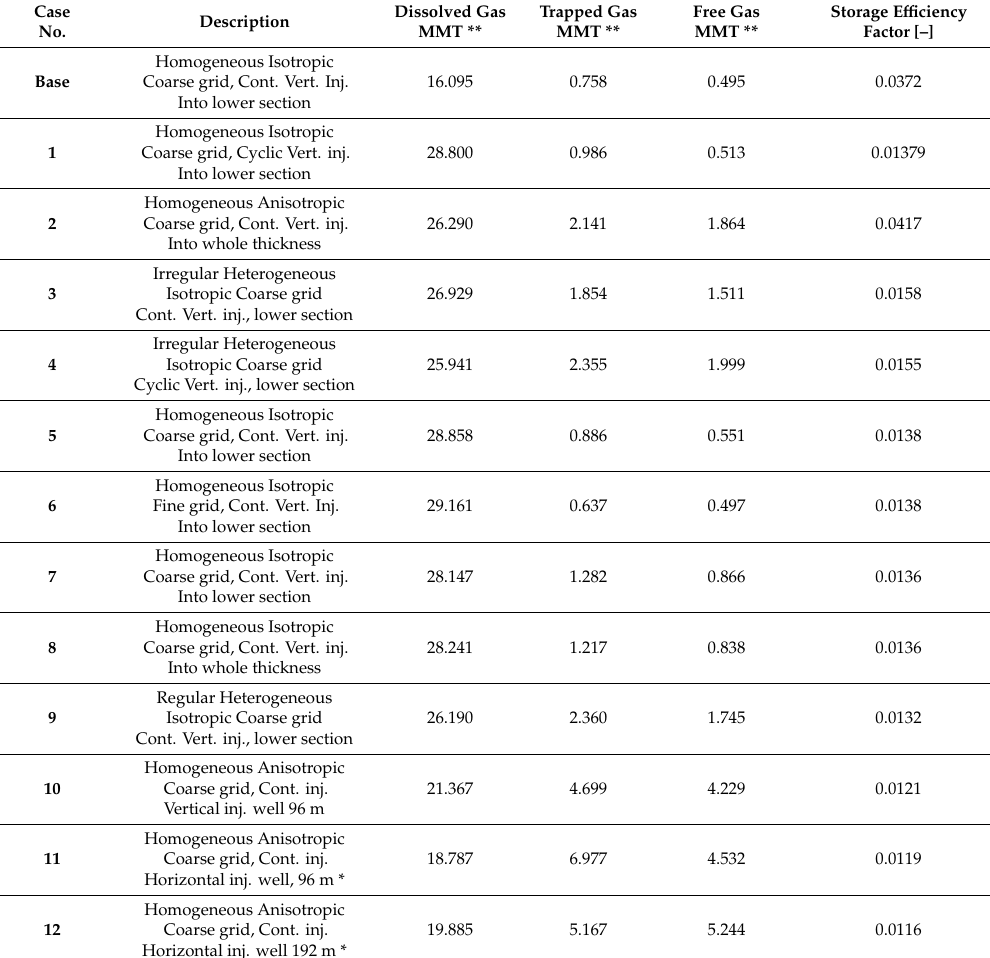
Figure 8. Impact of cyclic injection on different integrated CO 2 phases in DSAs for cases 1, 5, 3 and 4 in Table 3, respectively. Table 4. Simulation results and calculated e ffi ciency factor for all modelled